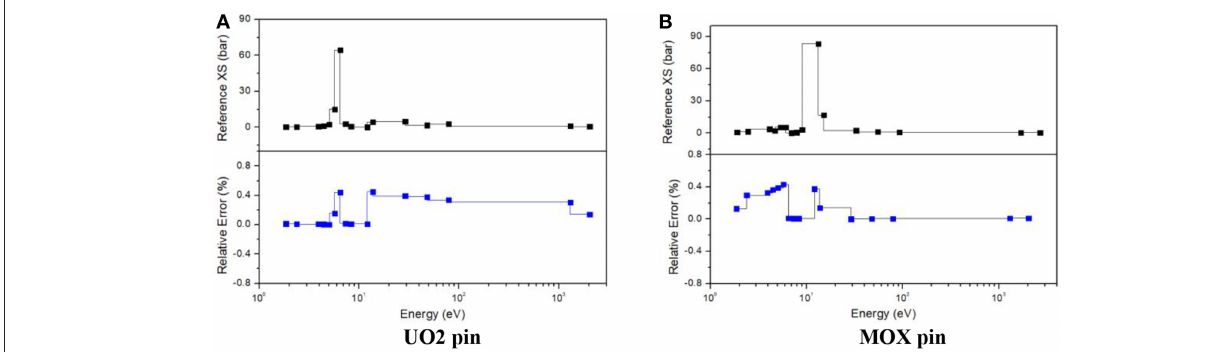
FIGURE 5 | Errors of U-238 absorption cross section of single cell. (A) UO2 pin, (B) MOX pin.